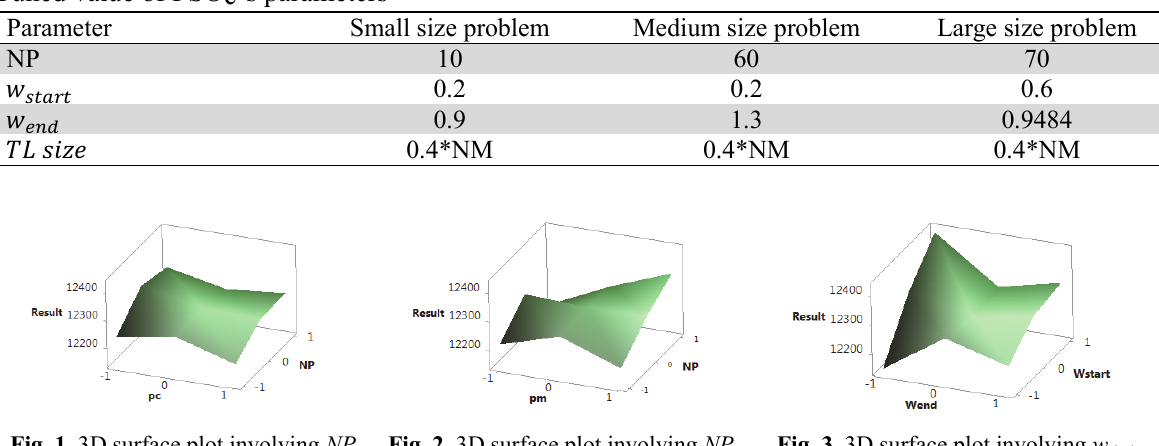
Tuned value of PSOc’s parameters